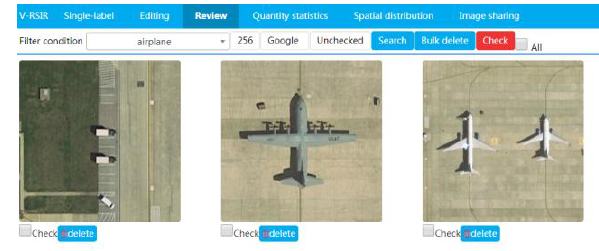
Figure 7. Interface of image review